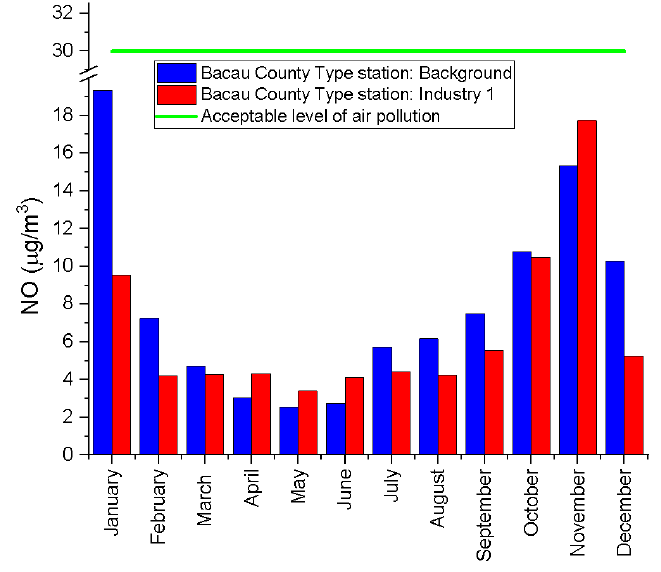
Figure 21. Average NO concentration in individual months of 2020.